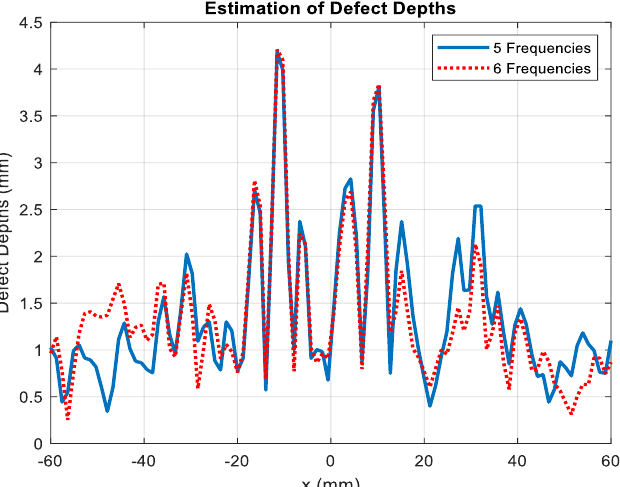
Figure 13. Thickness estimation of defects with a depth of 4 mm using data at 5 and 6 resonant frequencies.